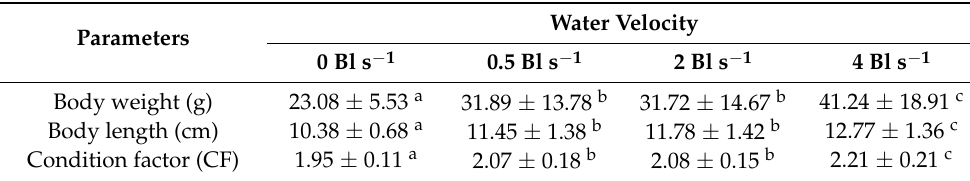
Table 2. Growth parameters of juvenile grass carp in the lotic environment.